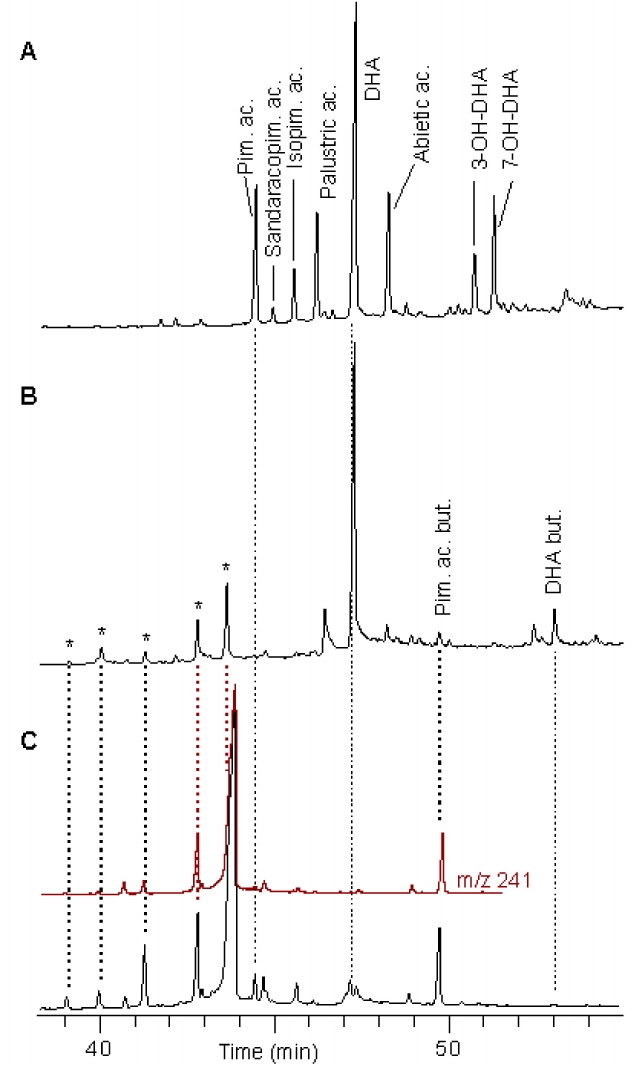
Figure 3. TIC Chromatograms. ( A ) Standard colophony extracted with DCM:MeOH; ( B ) standard colophony extracted with MW-assisted butylation and ( C ) standard pimaric acid extracted with MW- assisted butylation with m / z 241 chromatogram. ac.: acid; but.: butylated; *: unidentified